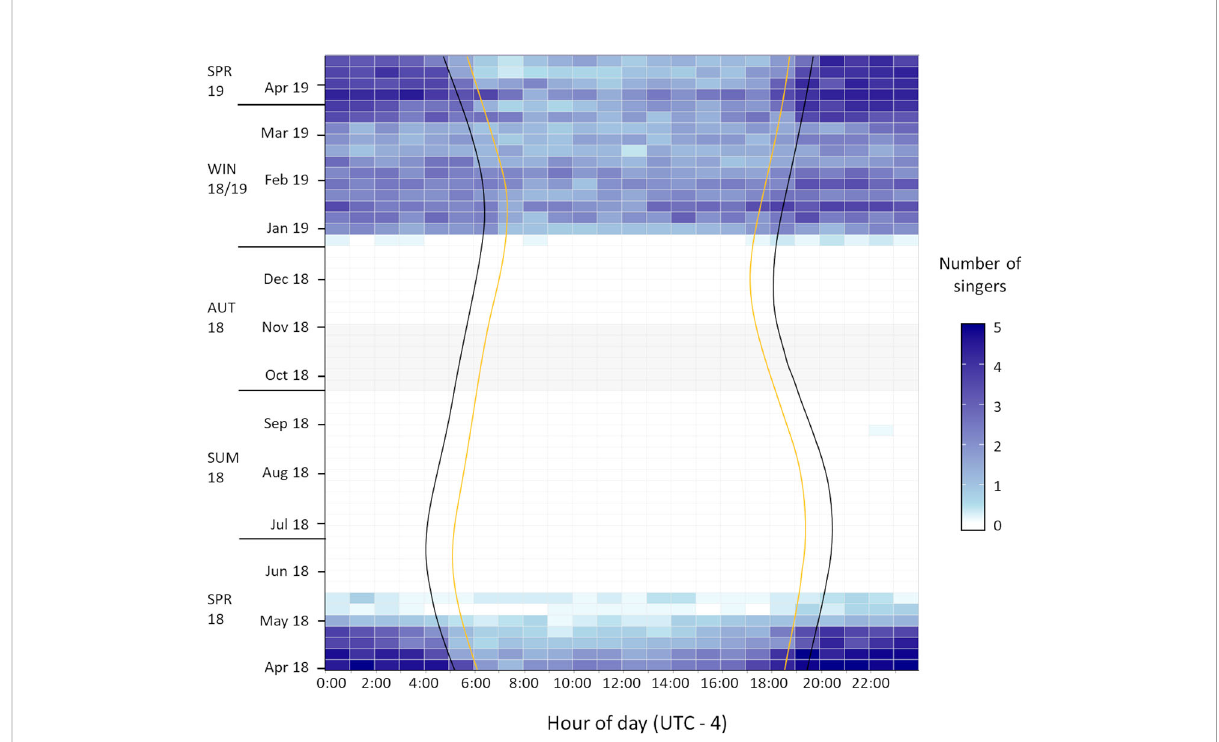
FIGURE 3 Seasonal occurrence and diel pattern of humpback whale song on Challenger Bank encountered across 55 weeks between 2018 and 2019. Sunset to sunrise (yellow lines) de fi nes daytime, dusk to dawn (black lines) de fi nes nighttime and the two remaining time intervals de fi ne the twilight periods. Grey shaded fi elds indicate no available recordings due to technical failure of the recording